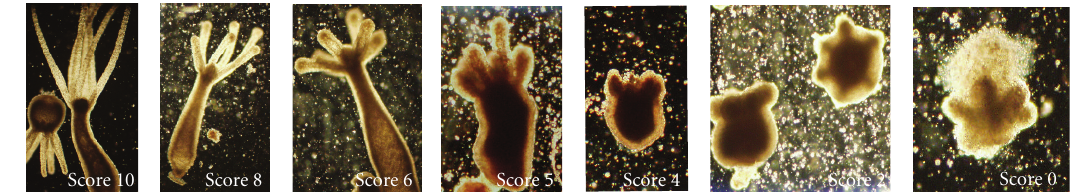
Figure 2: Example of morphological alterations induced by the treatment of living Hydra with CdTe QDs. Animals were incubated with increasing doses of TGA- and GSH-capped CdTe QDs, from left to right: 50nM, 100nM, 200nM, 300nM, 500 nM, 750nM, and 1 μ M over a period of 2h and then imaged. Progressive morphological changes were scored from 10 down to 1, as previously described